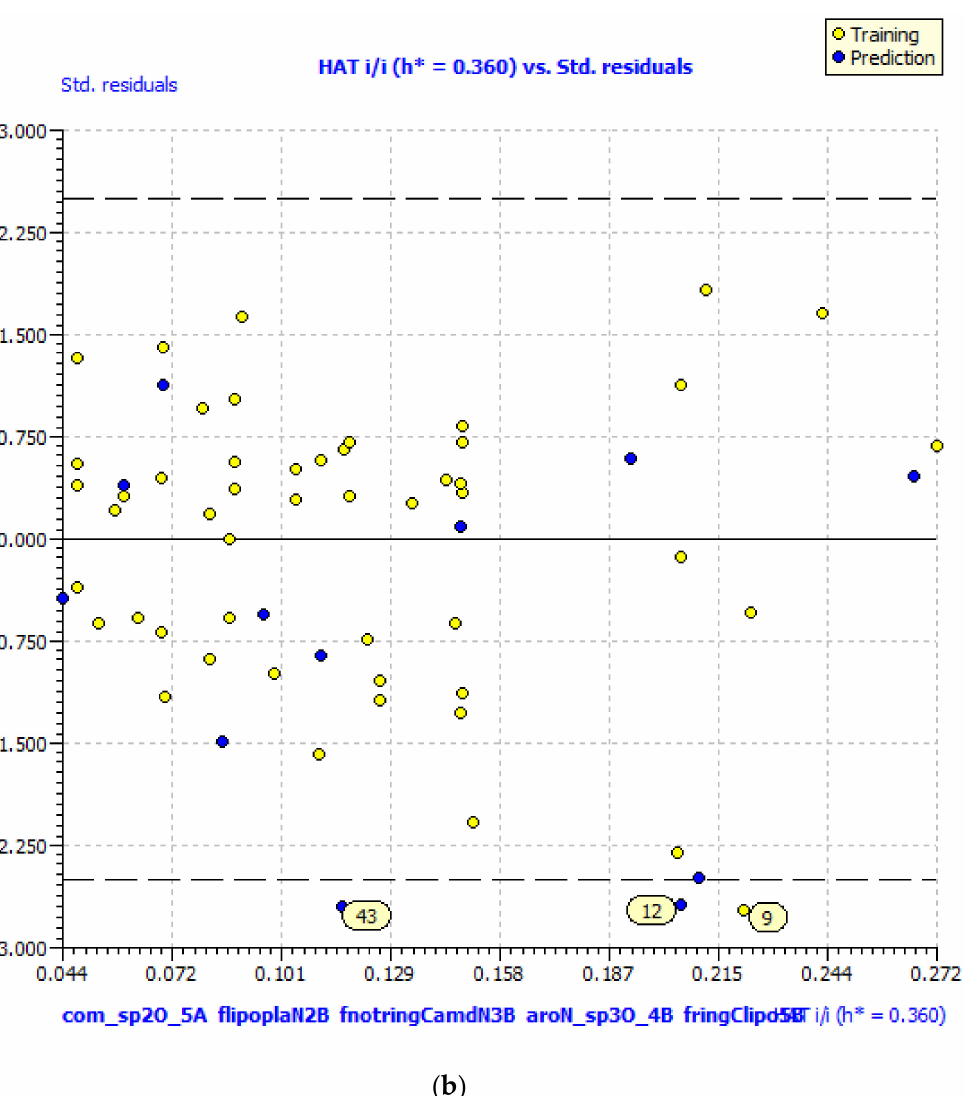
Figure 1. Different graphs associated with the developed Quantitative Structure − Activity Relationship (QSAR) model: ( a ) experimental vs. predicted pKi and ( b ) Williams plot to assess applicability domain of model. (molecules out of applicability domain have been shown with their serial